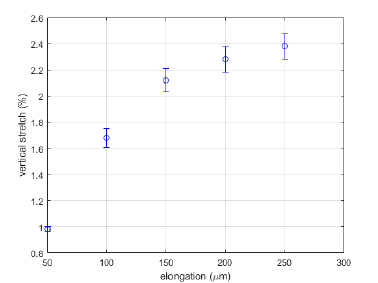
Figure 8. Vertical stretch evaluated from one-dimensional DIC.